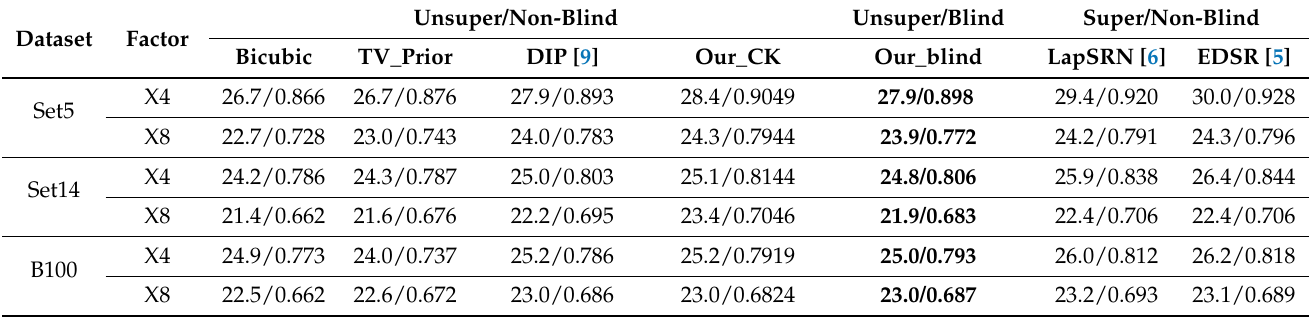
Table 2. Quantitative comparison of our proposed ZSB-SR with the sate-of-the-art methods. ( a ) On the simulated LR images of three benchmark dataset: Set5, Set14, and B100 with the degradation: bicubic downsampling. The first numerical result represents the PSNR value, and the second denotes the SSIM